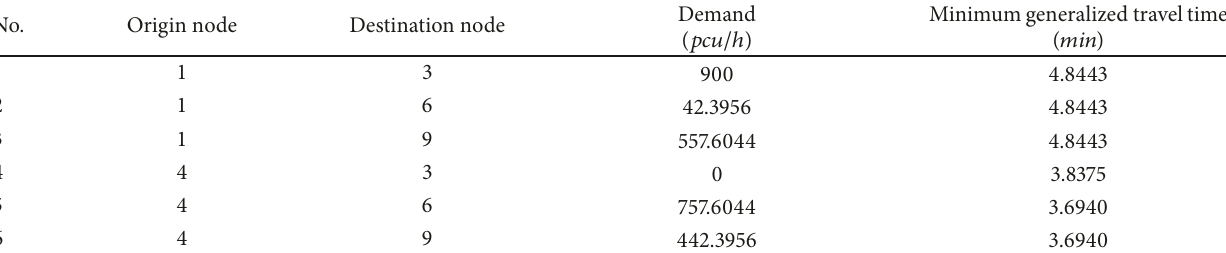
Table 6: Detailed information for OD